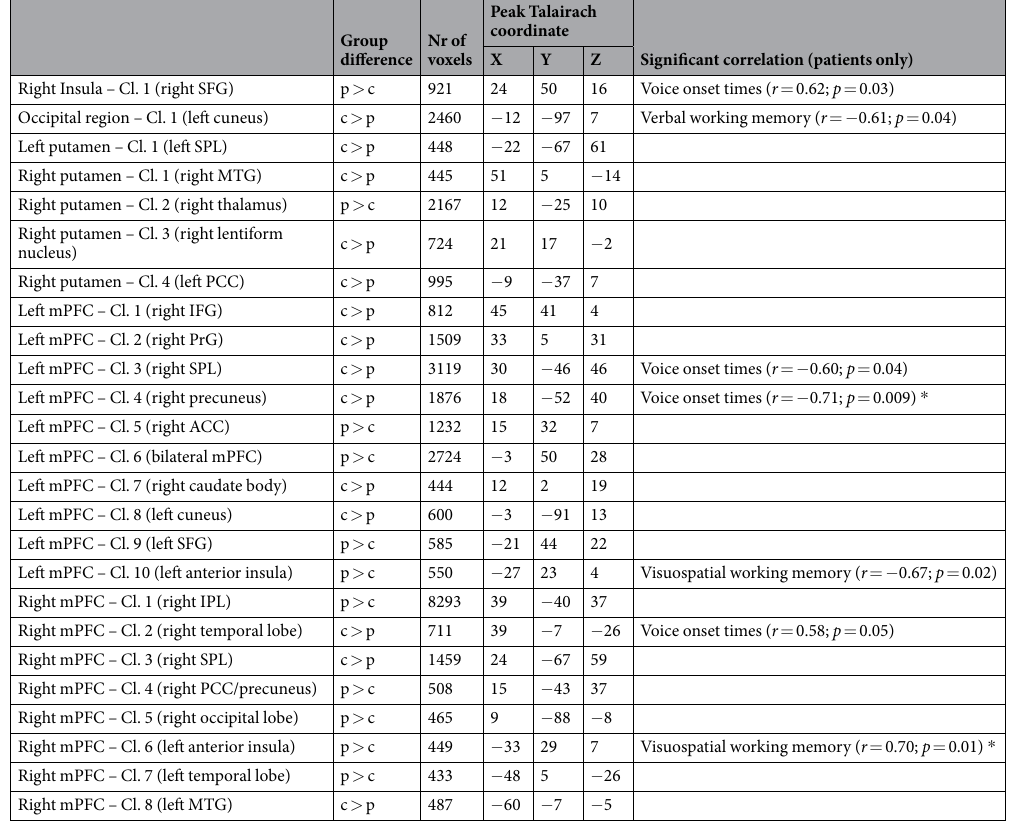
Table 1. Group differences per seed and significant correlations with neurocognitive tests. Clusters (cl.) of difference in functional connectivity between controls (c) and patients (p) specified per seed. Size and peak Talairach coordinates of each cluster are presented. Furthermore, significant correlations between clusters and neurocognitive test results are shown (for patient group only); clusters surviving a Bonferroni correction are marked ( * ). Tests used: Rey Immediate T-score for visuospatial working memory 74 , Digit span for verbal working memory 75 , Bourdon-Vos mean Reaction Time for sustained attention 76 , voice onset times for language production 12